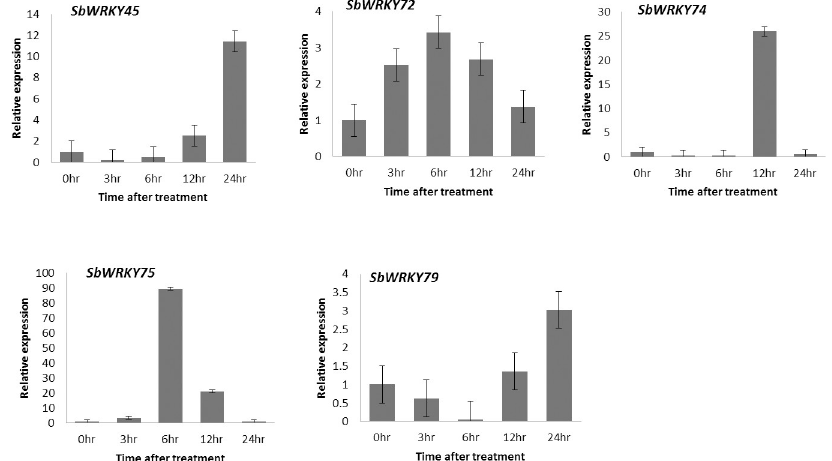
Fig 7. Relative expression of selected SbWRKY genes in response to drought stress. Relative expression levels of five SbWRKY genes under drought stress. Genes expression was analyzed by RT-qPCR, with the 0 h sample used as untreated control (expression = 1). Error bars represent standard errors; data were calculated using the 2 – ΔΔ Ct method.